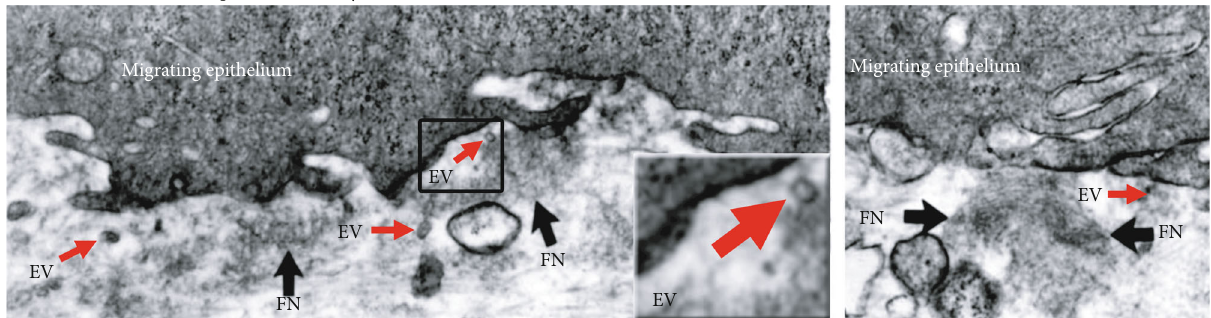
Figure 1: Transmission electron microscopy (TEM) images of a rabbit cornea 3 days postkeratectomy. The presence of EVs ( red arrow s) and fi bronectin (FN, black arrows ) is seen within the anterior stroma near the migrating epithelium. Original magni fi cation: 31,200x. Inset magni fi cation: 2.5x. Images were modi fi ed and reproduced from Zieske et al. 1987 [41] with permission from Dr. James D. Zieske (author), ARVO (copyright holder).